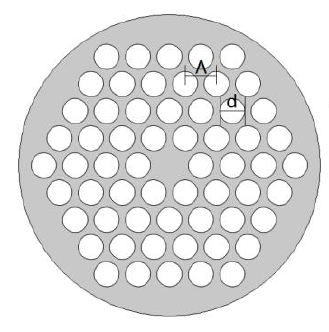
Figure 2. The cross profile of the photonic crystal fiber (PCF).